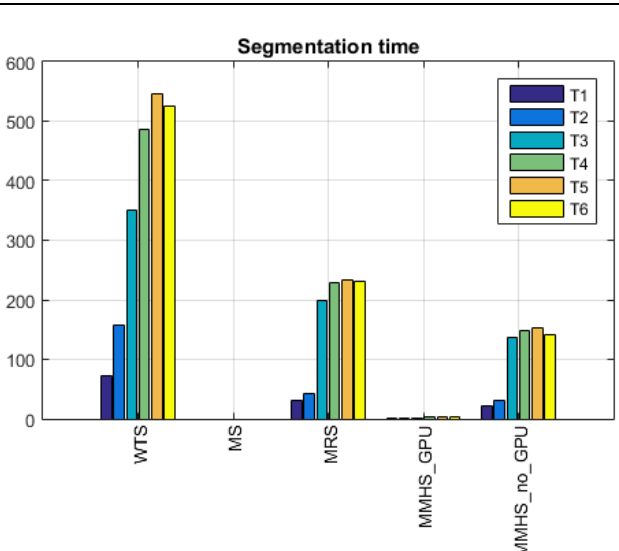
Figure 15. Segmentation time histogram of WTS, MS, MRS, MMHS_GPU, and MMHS_no_GPU.